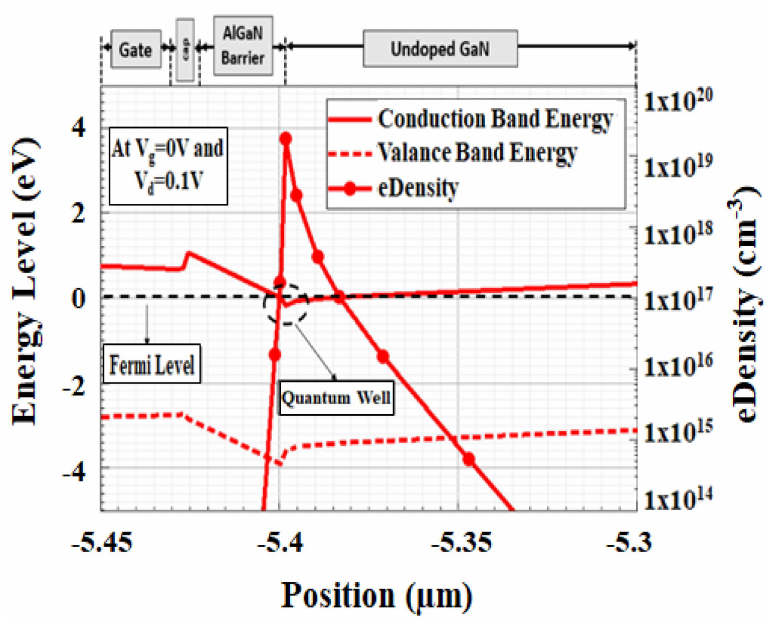
Figure 3. Simulated energy band diagram and electron density for GaN/AlGaN/GaN HEMT device by drawing the vertical cutline along the device.